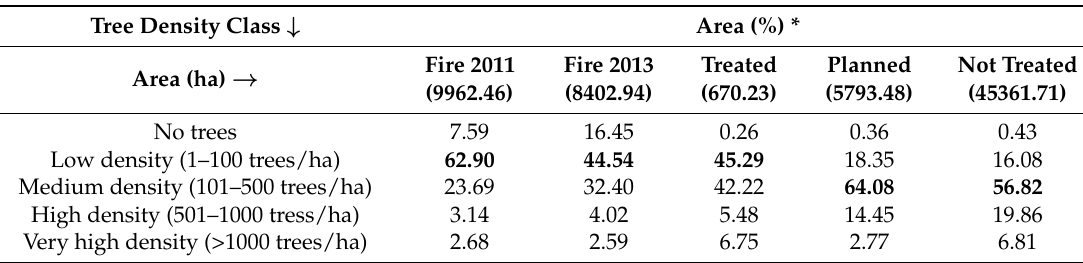
Table 2. Tree density as of June